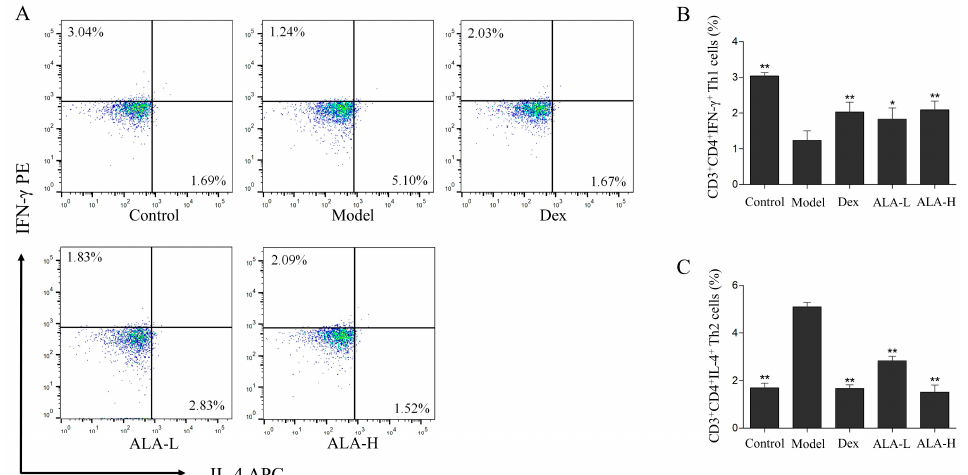
Figure 4. Effect of ALA on the percentages of CD3 + CD4 + IFN- γ + Th1 and CD3 + CD4 + IL-4 + Th2 cells in the spleen of AR mice. Representative dot plots of CD3 + CD4 + IFN- γ + Th1 (in the upper left quadrant) and CD3 + CD4 + IL-4 + Th2 cells (in the lower right quadrant) ( A ), and the percentages of CD3 + CD4 + IFN- γ + Th1 cells ( B ) and Th2 cells ( C ) in the SMCs separated from the spleen samples are analyzed via flow cytometry. Between-group comparisons were performed using one-way ANOVA coupled with LSD t -test (equal variances assumed) or Tamhane’s T2 test (equal variances not as- sumed). Data are expressed as mean ± SD; n = 3; * p < 0.05, ** p < 0.01 versus AR model. Dex, dexa-